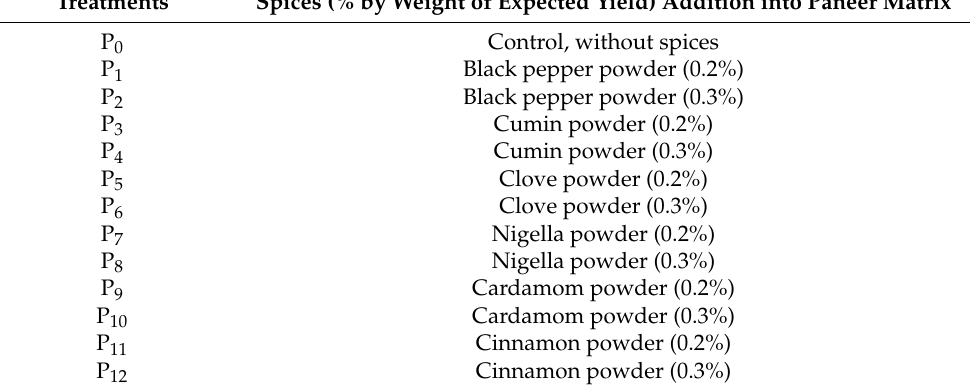
Table 1. Treatment plan of the present study. Treatments Spices (% by Weight of Expected Yield) Addition into Paneer Matrix P 0 Control, without